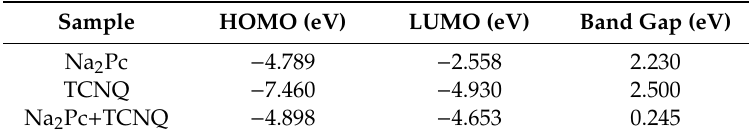
Table 1. HOMO, LUMO, and theoretical band